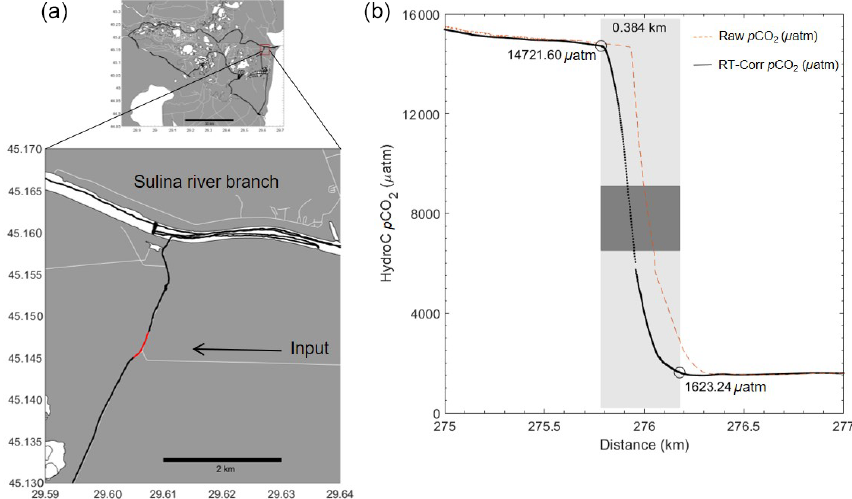
Figure 15. Extreme p CO 2 concentration gradient over a short time period ( ∼ 4min indicated by the red line on the map in panel a and a light grey box on the graph in panel b ) during Rom3. Raw p CO 2 (orange dashed line), compared with post-processed, response-time-corrected (RT-Corr) p CO 2 data (black), improving the spatial allocation of the gradient region by ∼ 100m. The gradient occurred over a distance of about 400m due to another channel providing a different water source (white lines indicating the channel). The dark grey box symbolizes the area over the concentration change in which the houseboat passed the entrance of the entering